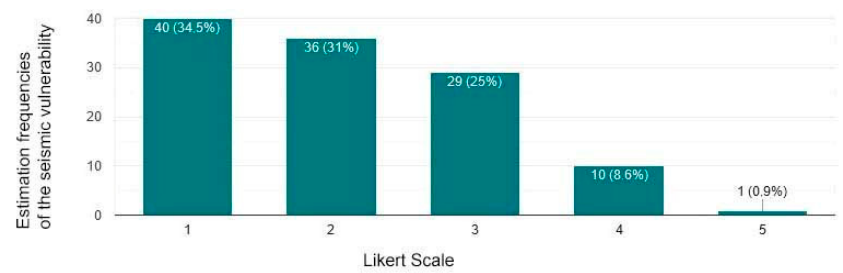
Figure 6. Seismic vulnerability of the WWTPs.